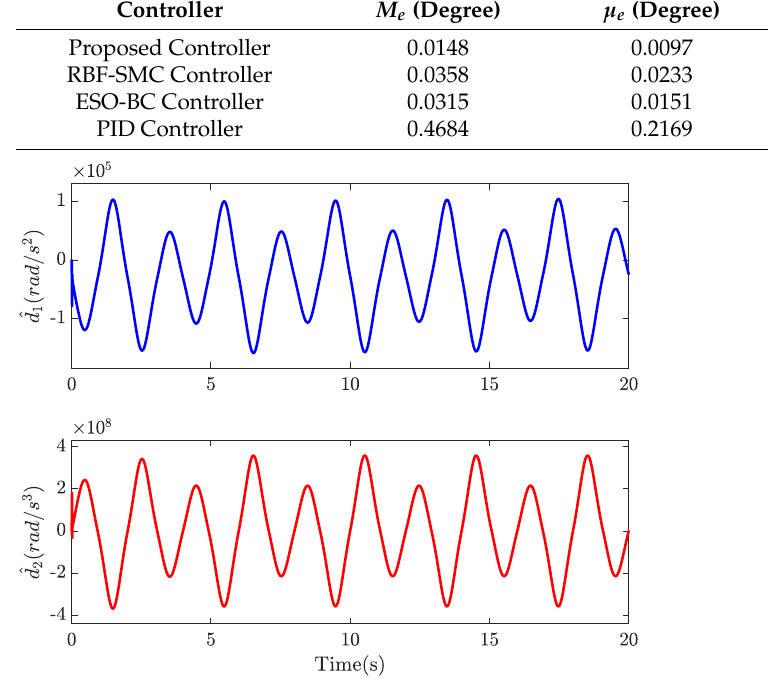
Figure 5. The estimates of the mismatched and matched disturbances of the proposed method.